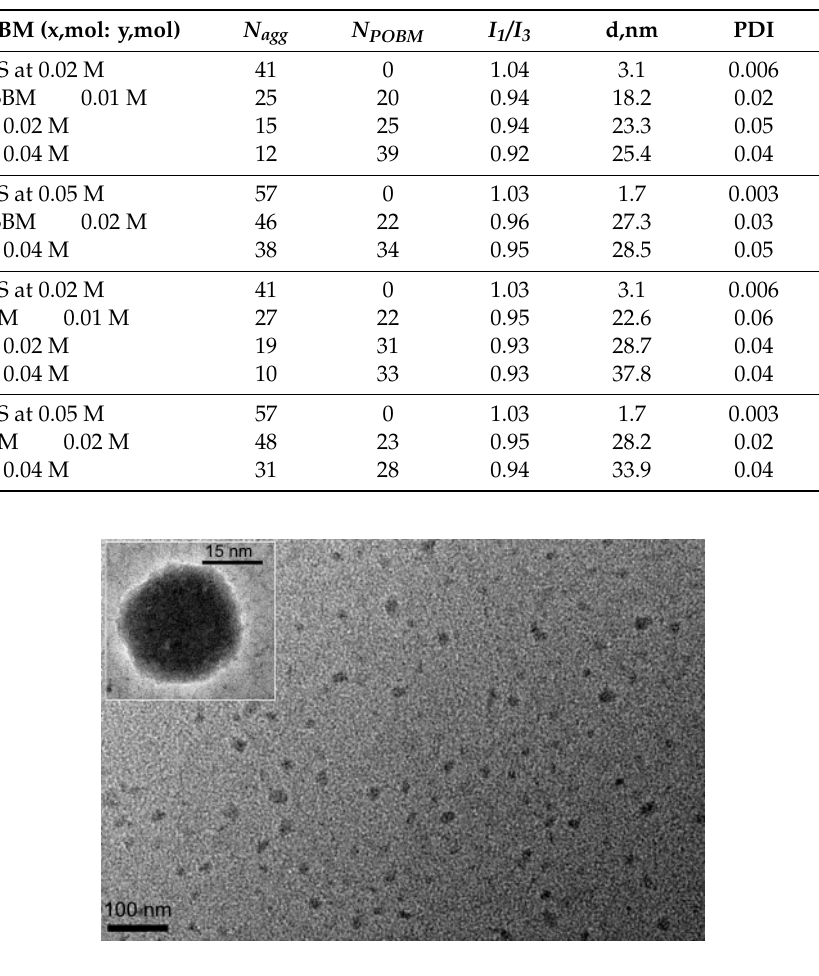
Figure 13. TEM micrograph of micelles prepared by mixing SDS (0.02M) and HO-SBM (0.01M) (inset shows morphology of selected individual micelle). Reprinted from Ref. 36, Copyright (2019), with permission from